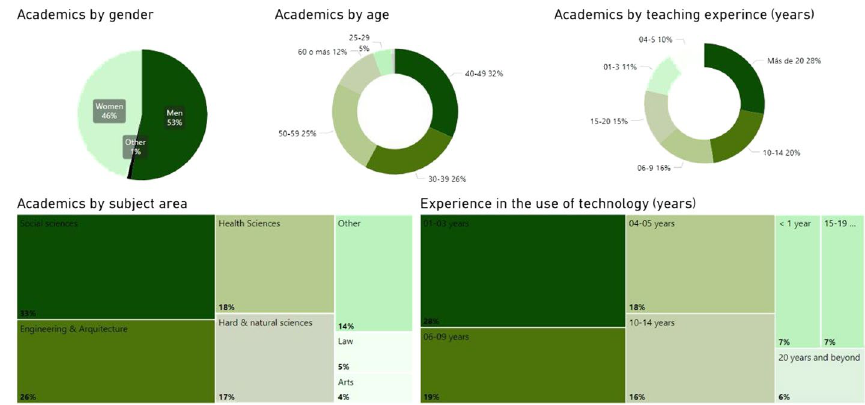
Fig. 1 General dashboard—profile of survey participants